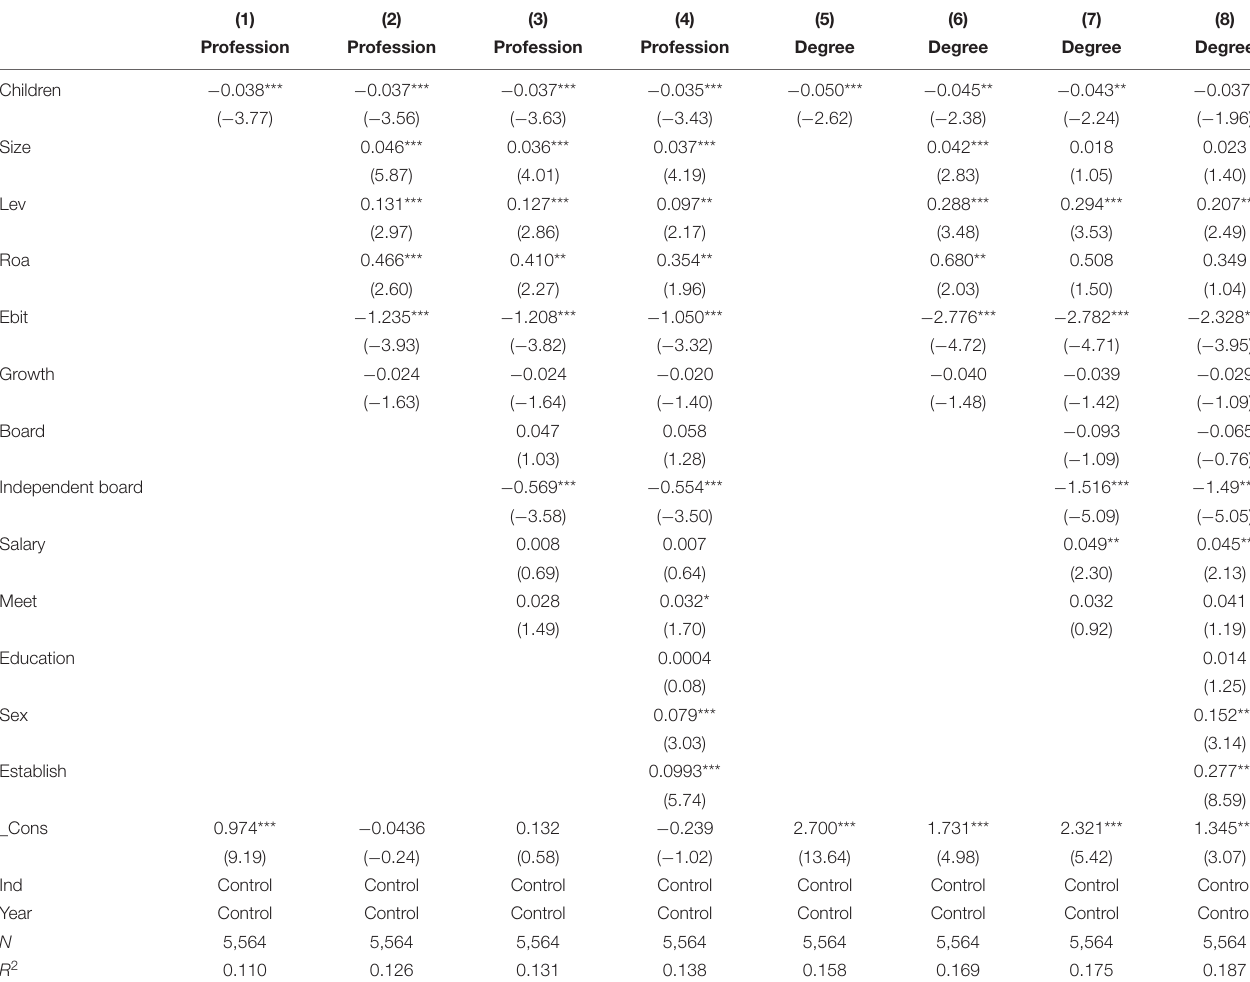
TABLE 4 | Multiple regression analysis: the number of children of actual controllers and professional